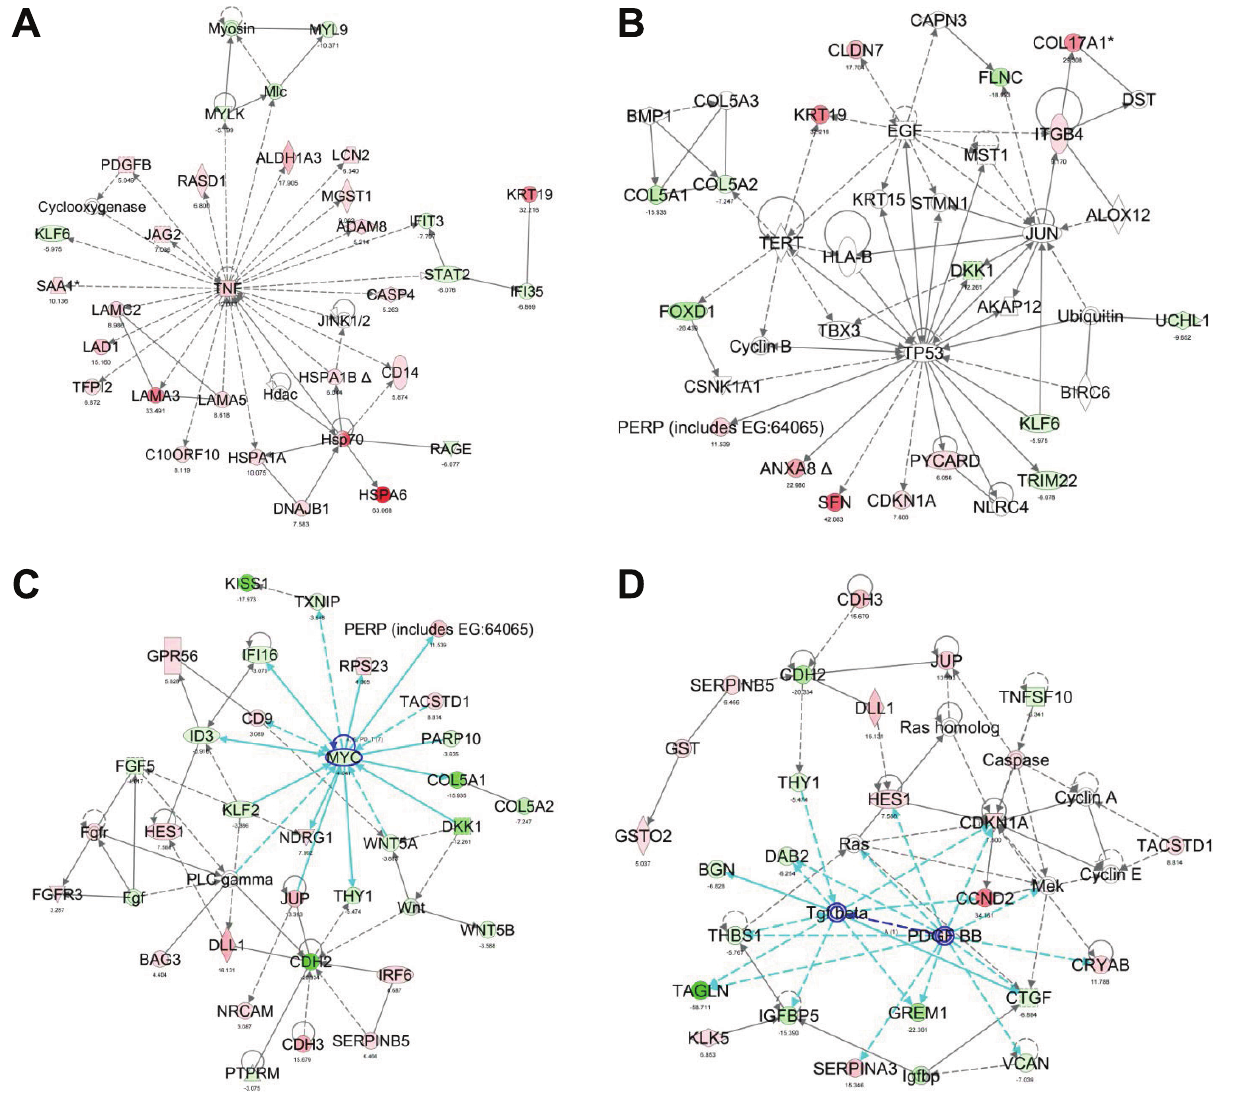
Figure 5. IPA network analysis of the NKX3.1 transcriptional program. ( A ) TNF α network. Node colors represent the level of up- (red) or down- (green) regulation upon expression of NKX3.1. ( B ) Tumor suppressor p53 network. The p53-TERT-EGF-JUN quadrangle is highlighted by dark blue edges. ( C ) MYC network. First degree edges of MYC are highlighted in light blue. ( D ) PDGFB/TGF β network. First degree edges are highlighted in light blue, the PDFGB-TGF β link in dark